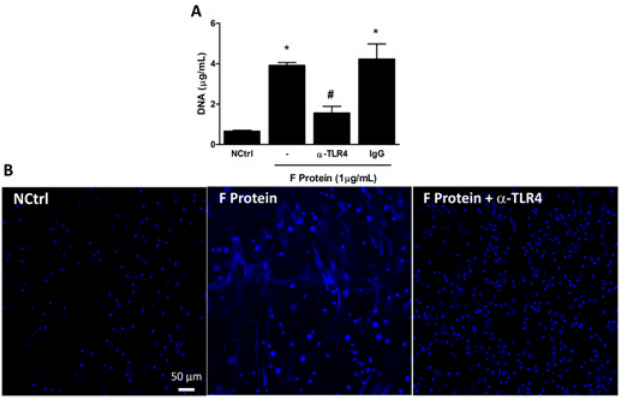
Fig 3. F protein-induced NET formation is dependent on TLR-4 activation. (A) Human neutrophils (2 x 10 6 /mL) were pretreated with monoclonal anti-TLR4 (10 μ g/mL) or isotype-matched (10 μ g/mL) antibody for 1 h and stimulated with F protein (1 μ g/mL) or medium for 3 h at 37°C with 5% CO 2 . NETs were quantified in culture supernatants using Quant-iT dsDNA HS kit. Data are representative of at least 3 separate experiments performed in triplicates and represent mean ± SEM. * p < 0.001 when compared to negative control (NCtrl); #p < 0.05 when compared to F protein-treated cells. (B) Neutrophils (2 x 10 5 /300 μ L) were pretreated with anti-TLR4 (10 μ g/mL) for 1 h at 37°C with 5% CO 2 and stimulated with F protein (1 μ g/mL) or medium for 3 h at 37°C with 5% CO 2 . Cells were fixed with 4% PFA and stained with Hoechst 33342 (1:2000). Confocal images were taken in a Zeiss LSM 5 Exciter microscope. Image is representative of 2 independent experiments. Scale bars = 50 μ m.